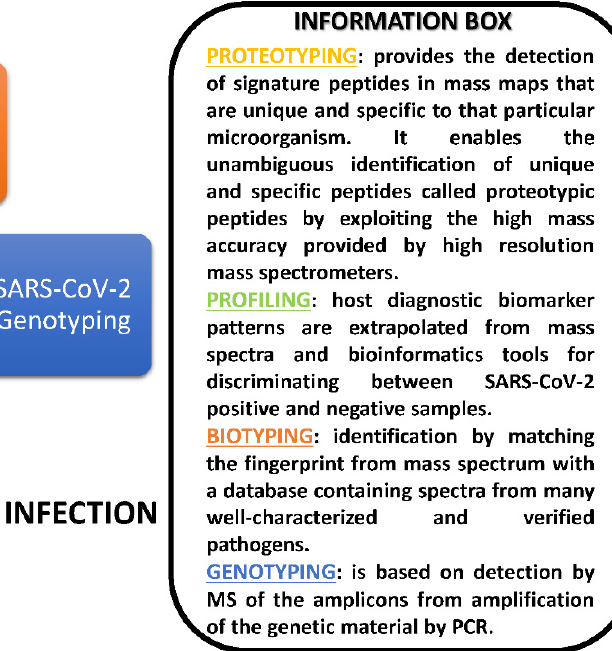
Figure 2. Overview of the MALDI-MS approaches for SARS-CoV-2 detection. MALDI-MS biotyping, proteotyping, and genotyping provide the direct detection of SARS-CoV-2. MALDI-MS biomolecular host profiling approaches uncover biomarkers associated with COVID-19.